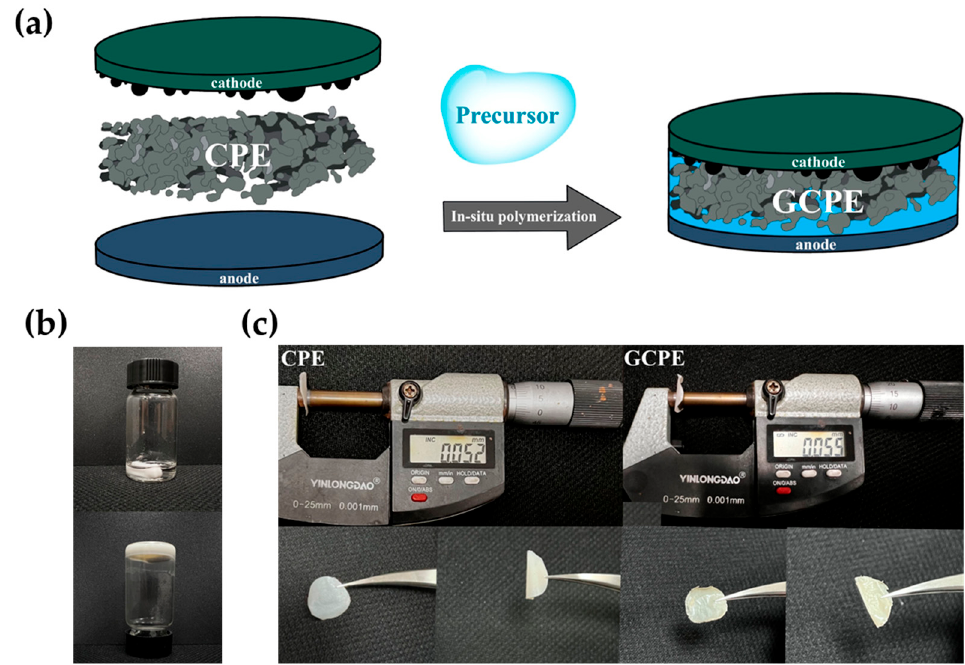
Figure 1. ( a ) Schematic diagram of in–situ polymerization work. ( b ) An optical picture describing the solidification of a material from a liquid state to a gel state. ( c ) Appearance and thickness mea–urement diagram of CPE and GCPE.